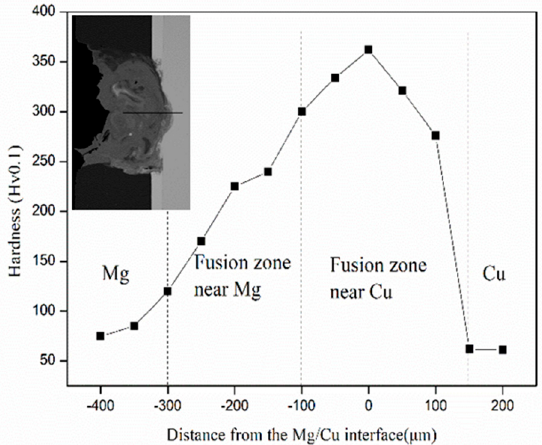
Figure 6. First-principles calculation results of MgZn: ( a ) Unit cell model; ( b ) Electron density map; ( c ) State density maps.